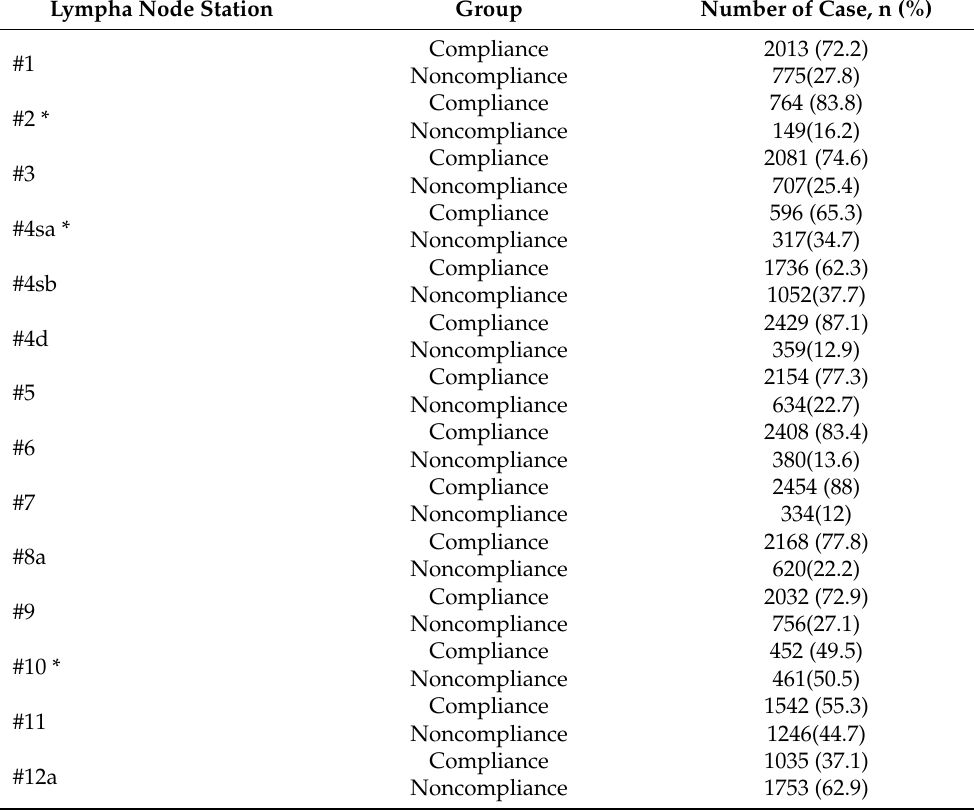
Table 1. Compliance for perigastric and extra-perigastric lymph node stations. Lympha Node Station